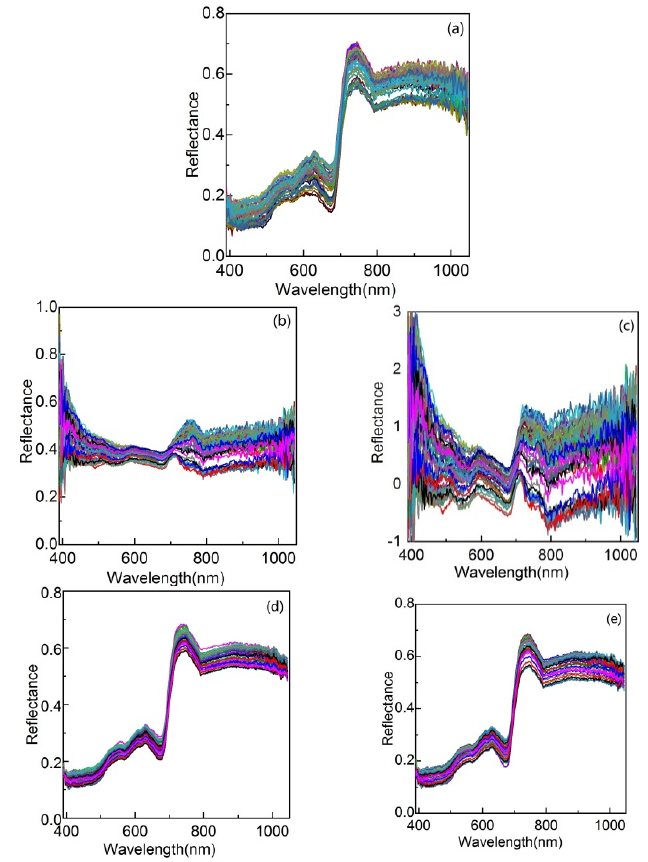
Figure 3. Spectral curve samples preprocessed by different methods. ( a ) Example of the spectral curve samples of anthracnose; ( b ) MSC; ( c ) SNV; ( d ) MAS; ( e ) SG. Table 3. Cucumber disease recognition accuracies under different preprocessing methods.